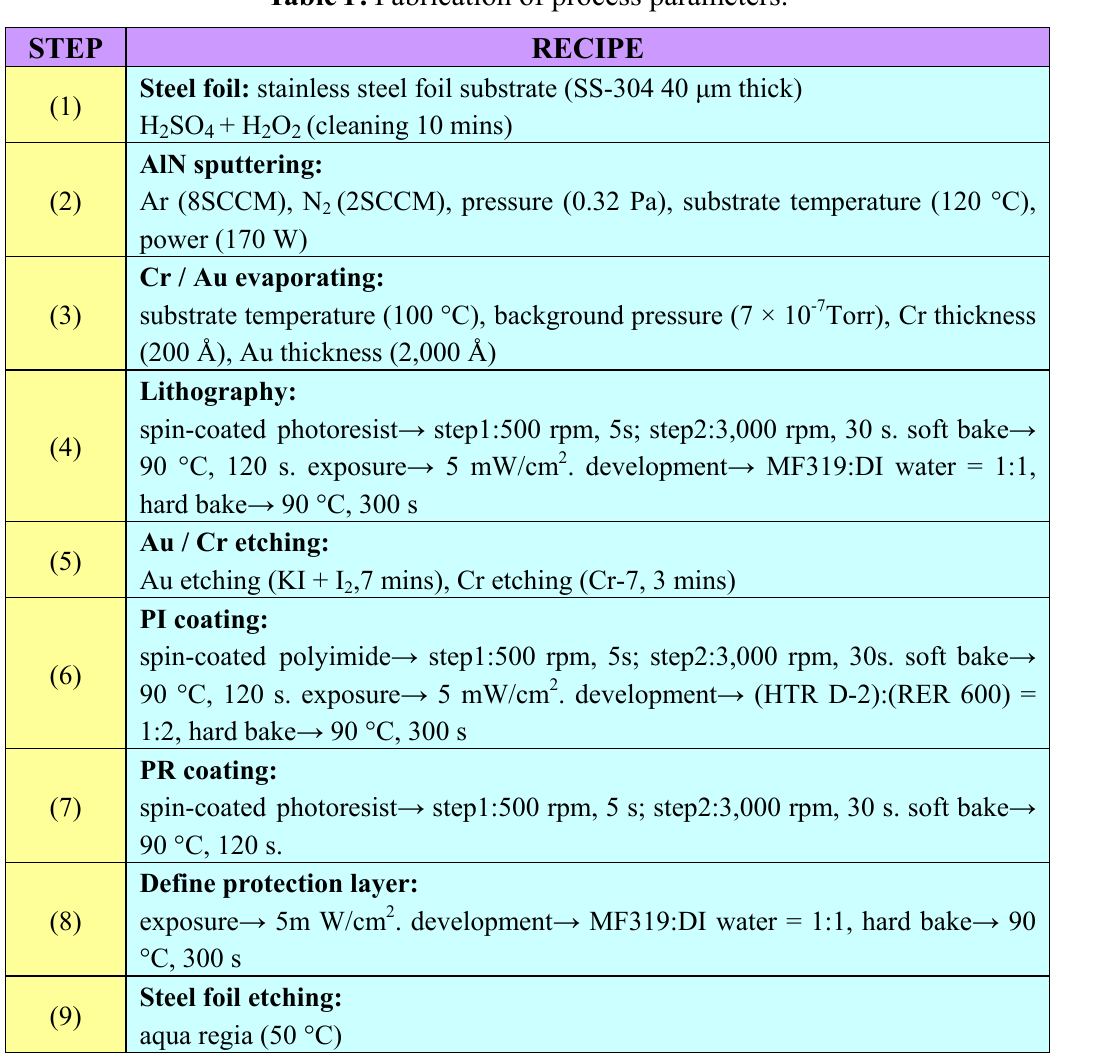
Table 1. Fabrication of process